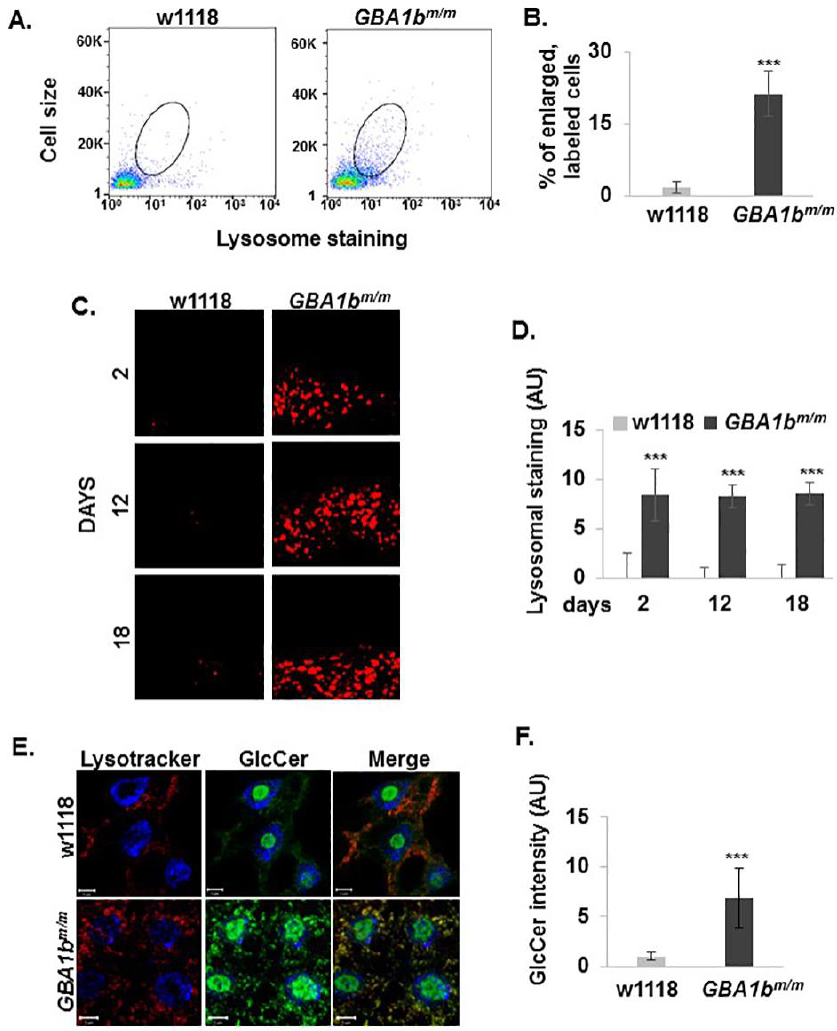
Figure 4. Changes in lysosomes morphology in GBA1b m/m flies. ( A ) Hemocytes were extracted from hemolymph of 12-day-old control (w1118) and GBA1b m/m flies, stained with LysoTracker-Red and analyzed by FACS. LysoTracker signal was measured by side scatter using 530 nm excitation (SSC:FITC_530) and cell size was measured by forward light scatter (FSC:LinH). LysoTracker-labeled hemocytes, larger than those extracted from w1118 flies, were encircled. ( B ). Quantification of encircled cells from (A). Presented is the average ± standard error of three independent assays. ( C ) Representative confocal images of the subesophageal ganglion of brains dissected from control (w1118) and GBA1b m/m flies at three different time points. ( D ) Quantification of LysoTracker in images as shown in (C). Presented is the average ± standard error of 30 images from each line. ( E ) Representative confocal images of Fat body dissected from third instar larvae of control (w1118) and GBA1b m/m flies, stained with Lysotracker and anti GlcCer antibodies. ( F ) Quantification of GlcCer signal as analyzed form confocal images as shown in ( E ). Presented is the average ± standard error of 30 images from each line. *** p <